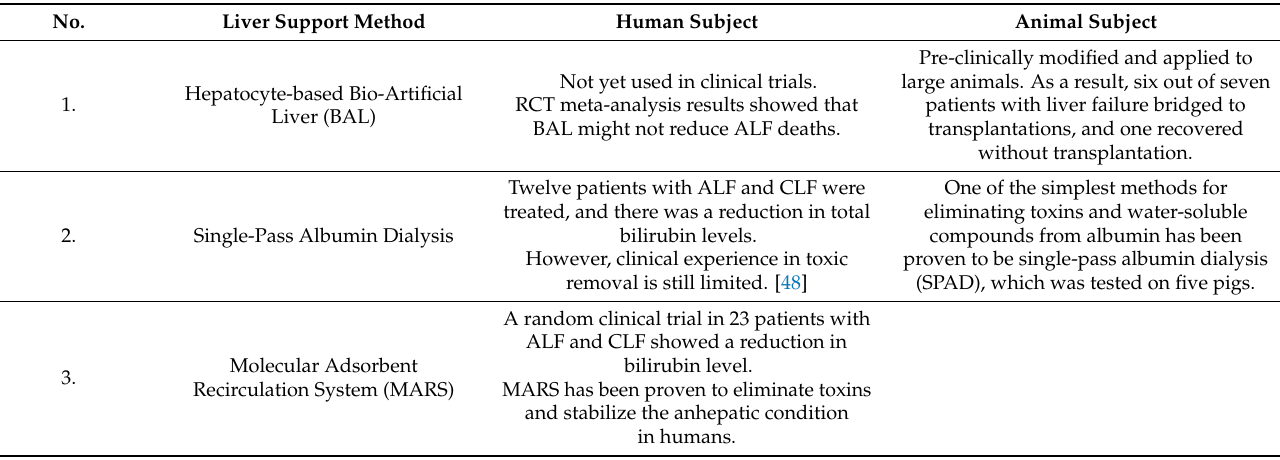
Table 2. The Comparisons of Human and Animal Subjects for Liver Support Study